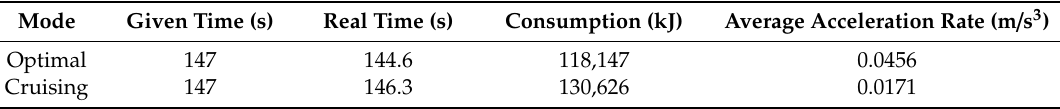
Table 7. Detailed data about the